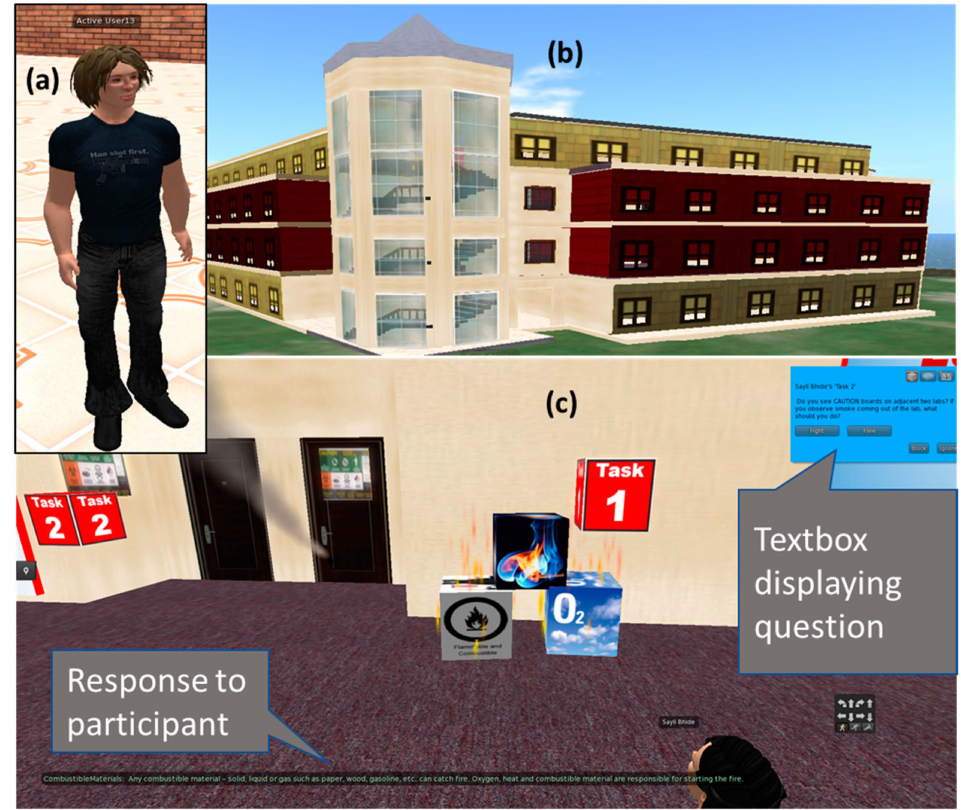
Figure 2. Details of the avatar and the virtual building built using OpenSim: ( a ) avatar of a participant; ( b ) virtual engineering building; ( c ) feedback in the